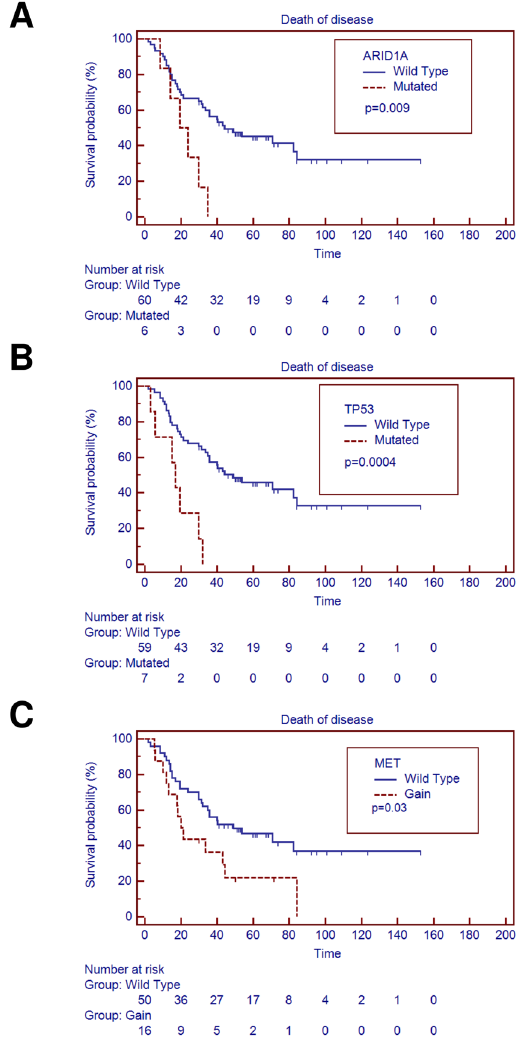
copy gain in MET gene ( p =